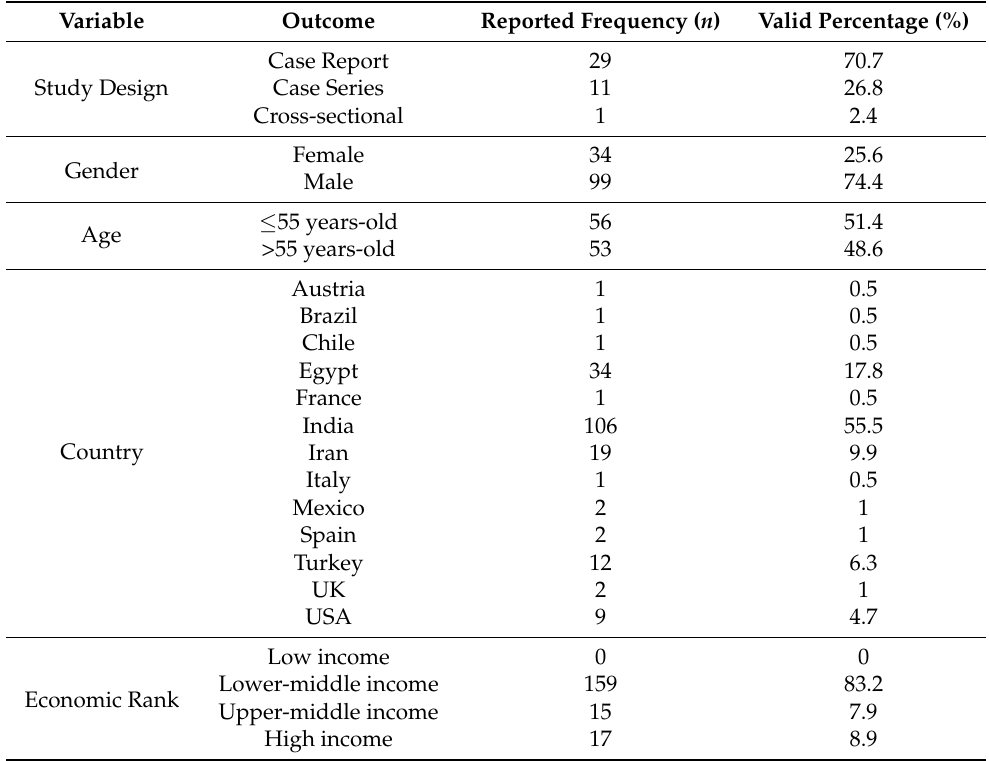
Table 2. Demographic Characteristics of COVID-19-associated Mucormycosis (CAM) Cases, Global